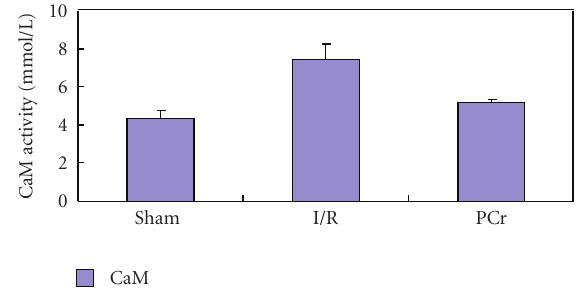
Figure 4: CaM activity (mmol · L − 1 ) was measured using rat CaM ELISA kit.